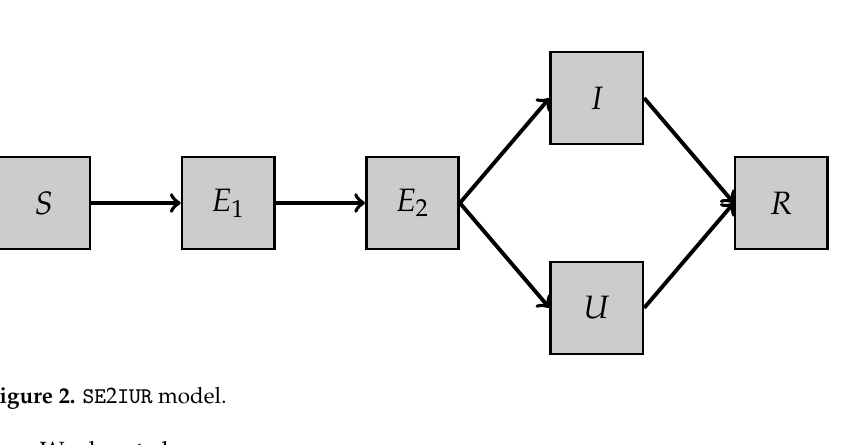
Figure 2. SE 2 IUR model.